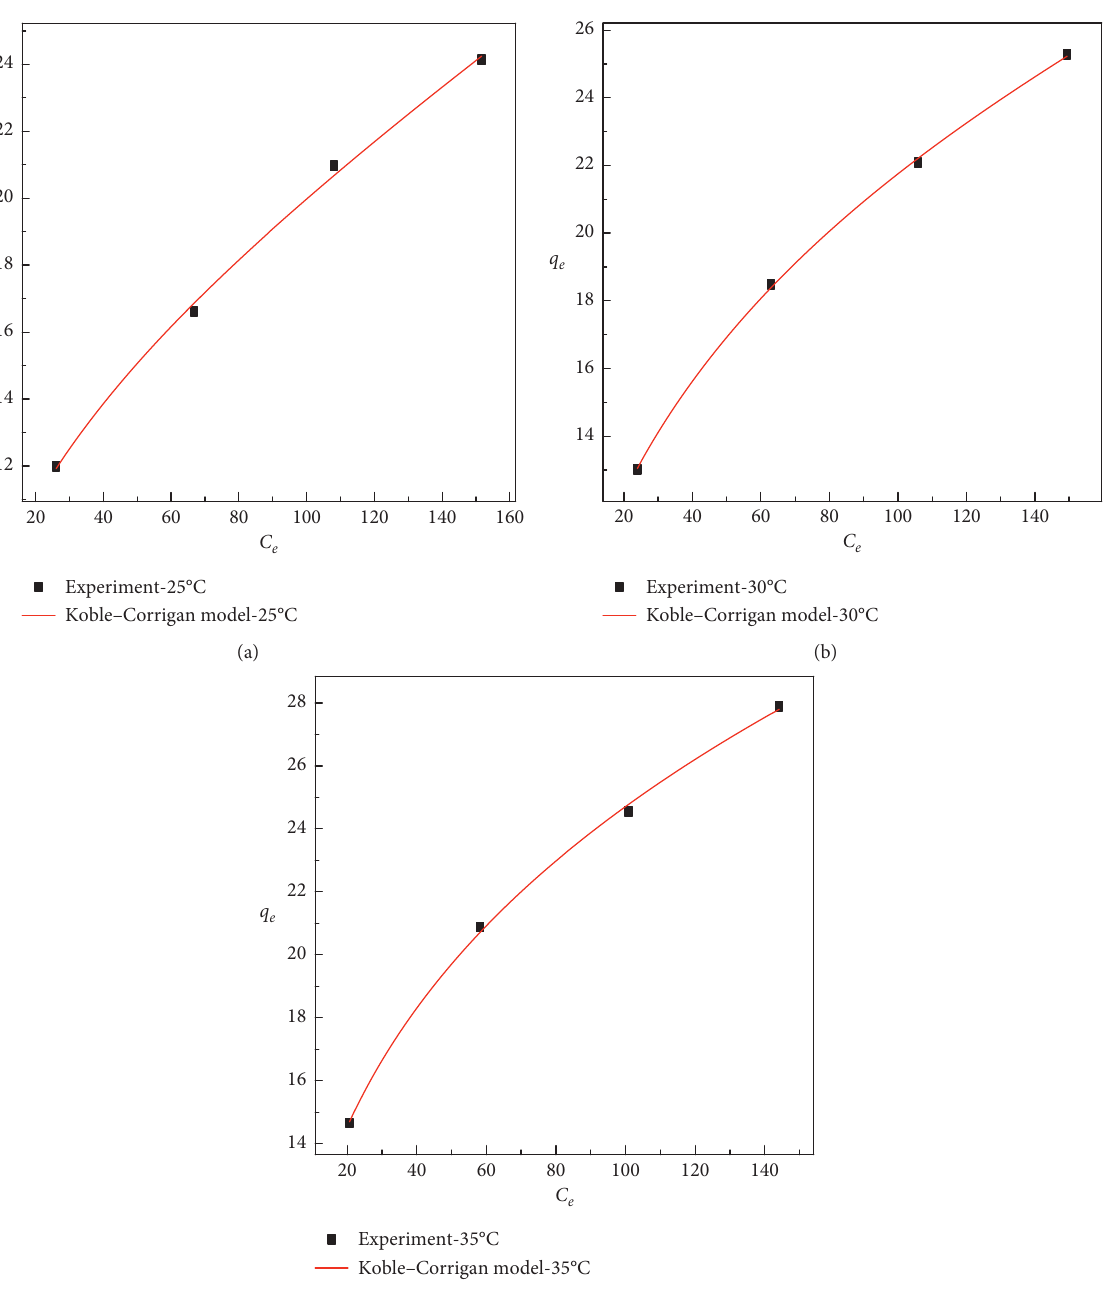
Figure 12: Koble–Corrigan isotherm plots for the uptake of ammonium on the